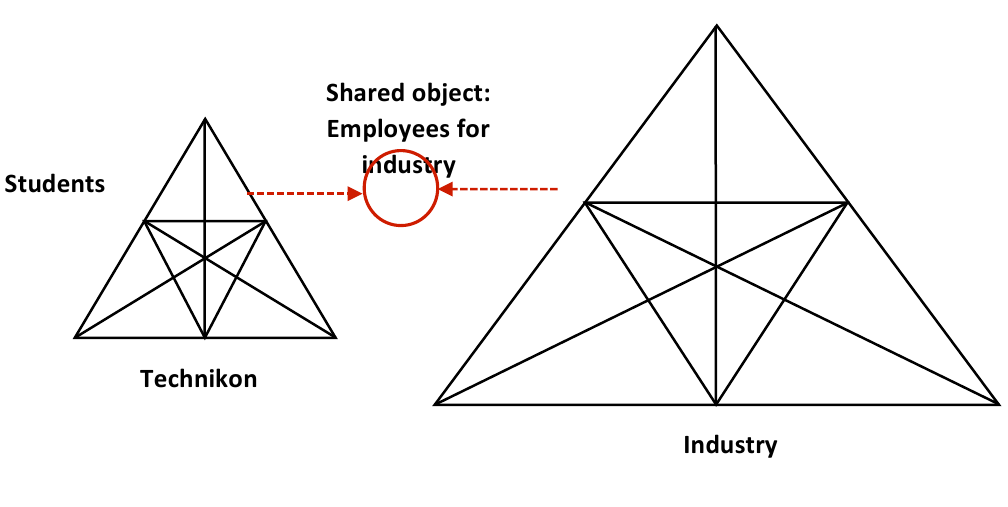
Figure 2: Training for